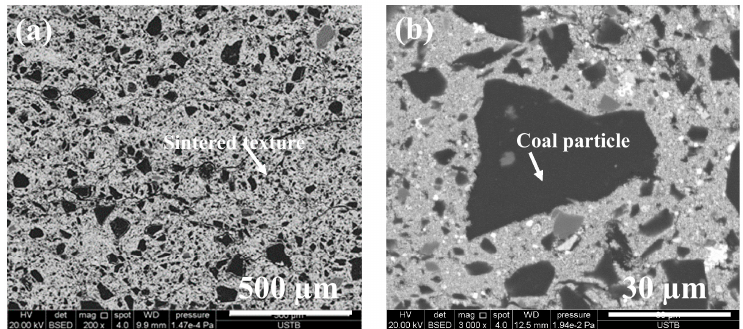
Figure 4. XRD pattern of the CCB sample.